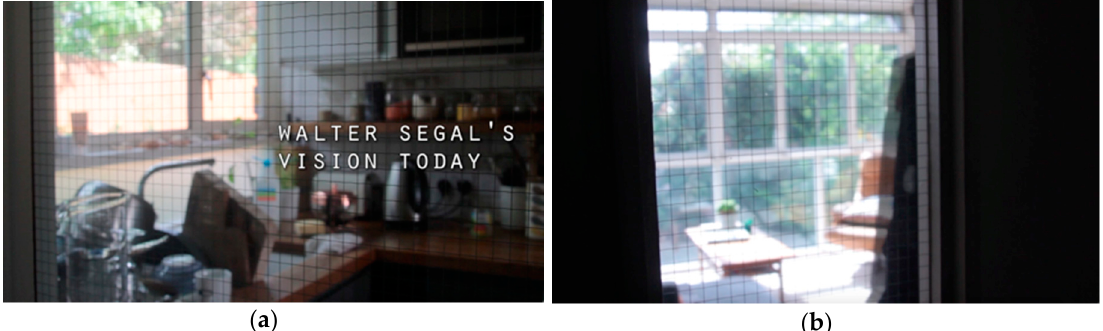
Figure 2. Vanessa Koepper: Social Housing in London: Walter Segal´s self-build houses: ( a ) View of a kitchen through a glass door; ( b ) View of a living room through a glass door.